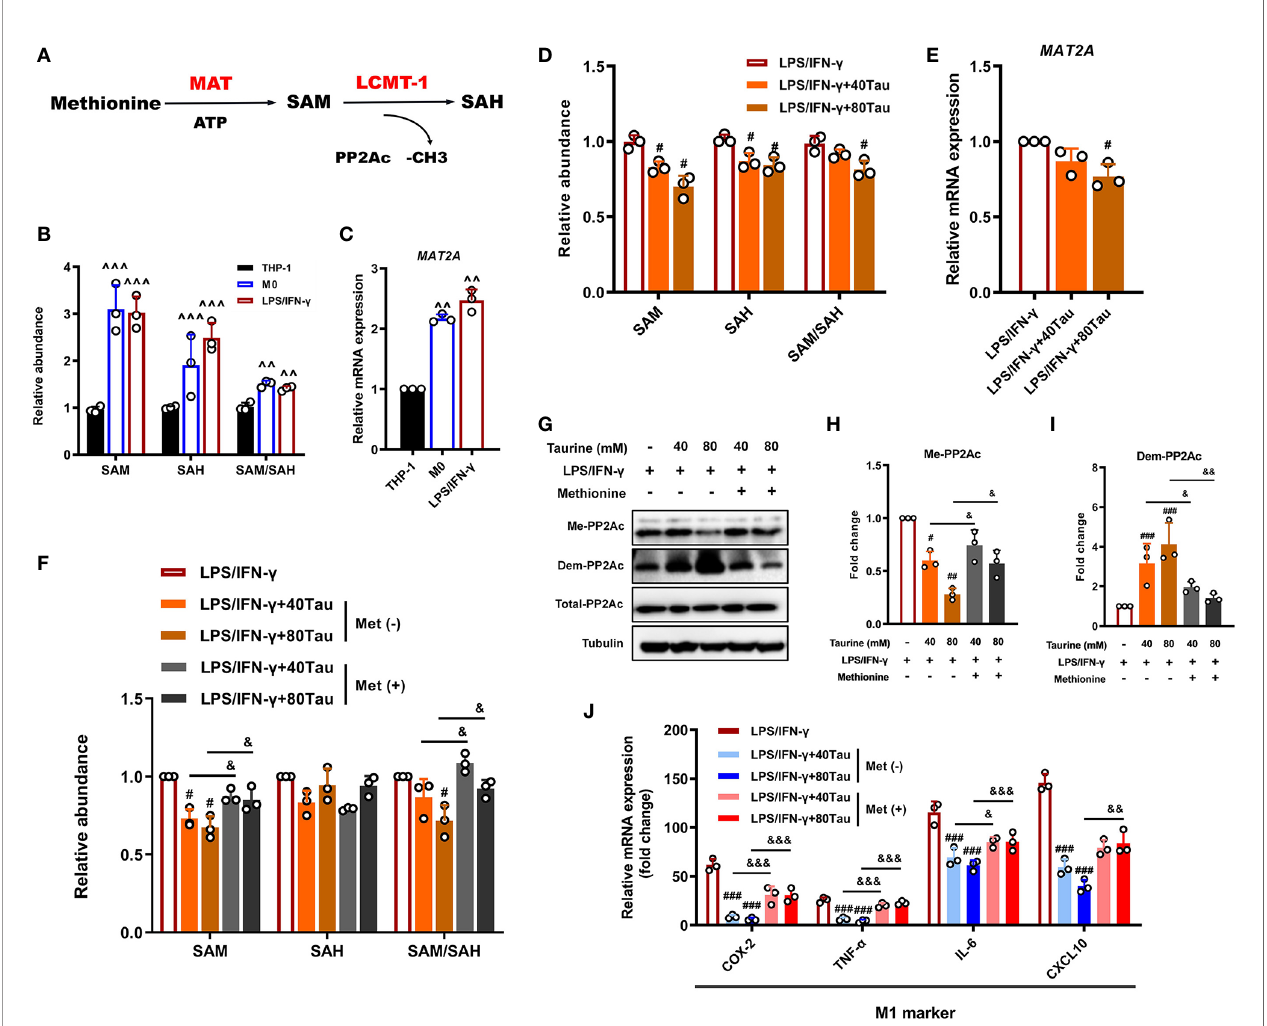
FIGURE 6 | Taurine prevents macrophage M1 polarization by reducing SAM synthesis. (A) Schematic representation of the generation of SAM and SAH from methionine and downstream PP2Ac methylation. (B) Levels of intracellular SAM and SAH in M1 polarization. (C) MAT2A mRNA levels in M1 polarization. (D, E) Levels of SAM and MAT2a mRNA in taurine-treated macrophages. (F) Exogenous methionine restores SAM production inhibited by taurine. (G) Representative immunoblots and (H, I) quantitation of total-PP2Ac, methylated-PP2Ac, and demethylated-PP2Ac with exogenous methionine. (J) mRNA levels of M1 markers with exogenous methionine. n=3. ^^p < 0.01 and ^^^p < 0.001 vs. THP-1; #p < 0.05, ##p < 0.01 and ###p < 0.001 vs. LPS/IFN- g ; &p < 0.05, &&p < 0.01 and &&&p < 0.001 vs.